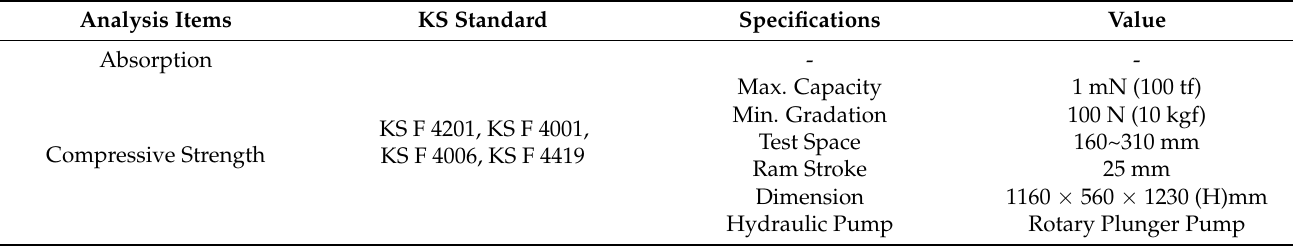
Table 6. Test methods and Instrument